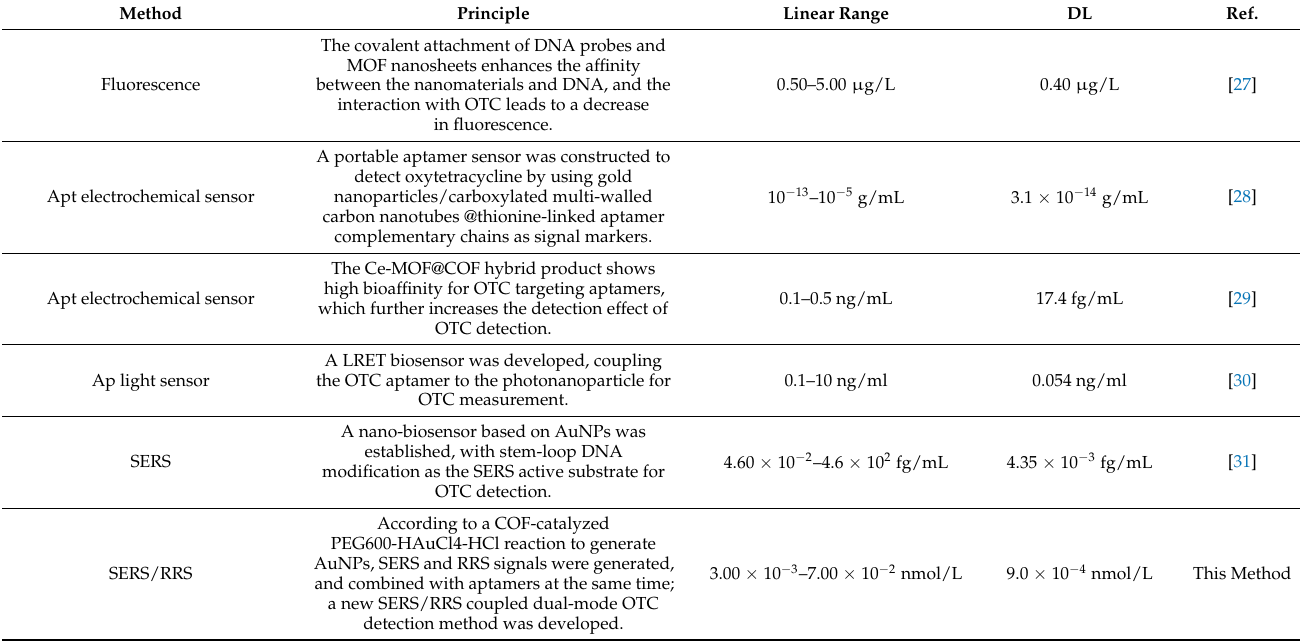
Figure A6. Optimization of analysis conditions. ( A ) Effect of PEG600 concentration. ( B ) Effect of HAuCl 4 concentration. ( C ) Effect of HCl concentration. ( D ) Effect of DdBd concentration. ( E ) Effect of Apt OTC concentration. ( F ) Effect of reaction temperature. ( G ) Effect of reaction time. Table A1. Comparison of DdBd nanocatalysis characteristics of glycol/PEG systems. Table A2. Comparison of reported OTC analysis